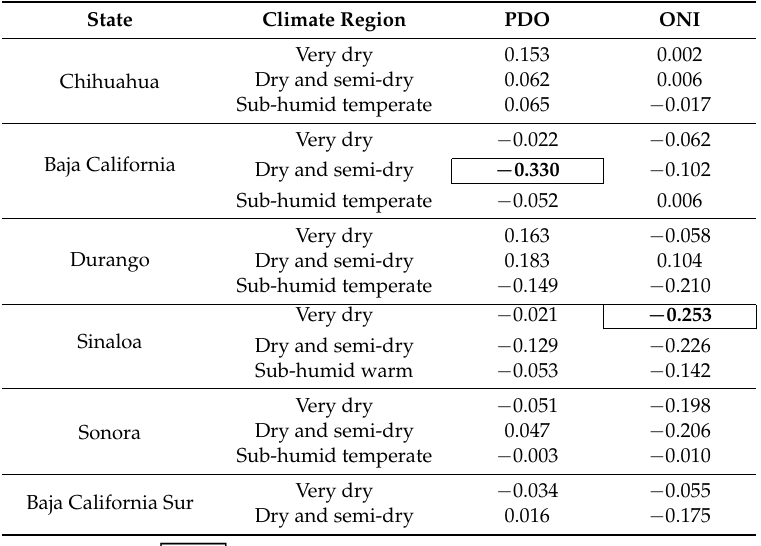
Table 6. Correlation analysis for standardized precipitation evapotranspiration index on a three-month scale (SPEI-3), Pacific decadal oscillation (PDO) and oceanic El Niño index (ONI) in the period 1952–2013 in northern Mexico. Source: Authors, following INEGI climatic classification (http: //www.cuentame.inegi.org.mx/monografias/) and databases: http://sac.csic.es/spei/, https://